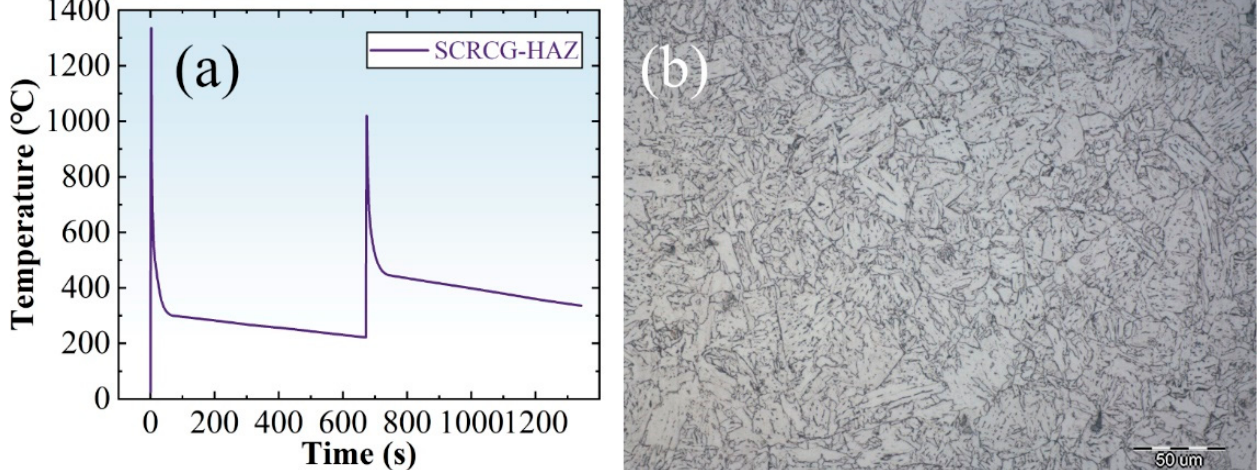
Figure 11. Thermal process of SCRCG-HAZ and the thermal simulation microstructures (with a magnification of 500): ( a ) thermal cycles calculated for thermal simulation of SCRCG-HAZ; ( b ) microstructures of thermal simulated SCRCG-HAZ.